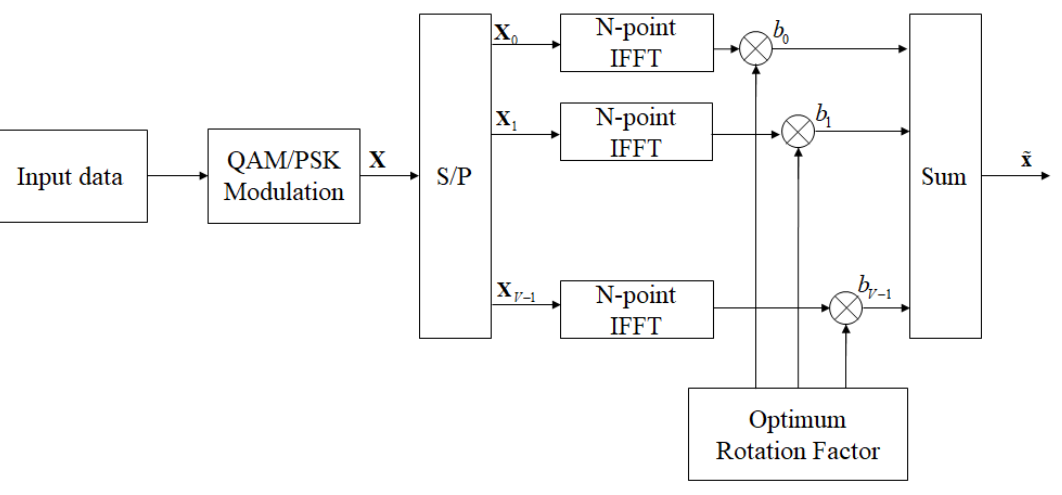
Figure 3. The block diagram of the PTS scheme in OFDM